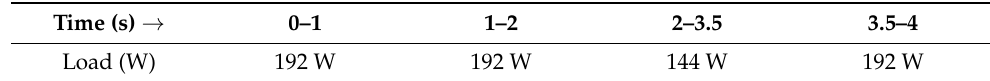
Table 4. Load variations at different intervals.